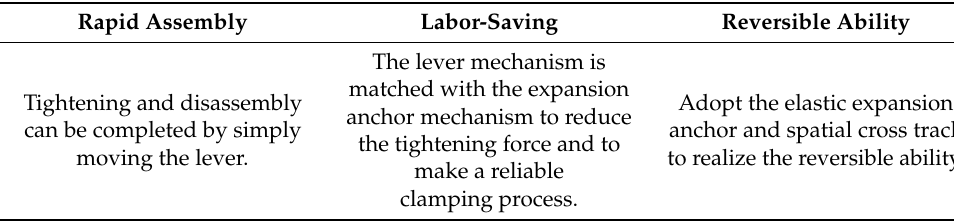
Table 4. Advantages of fast temporary